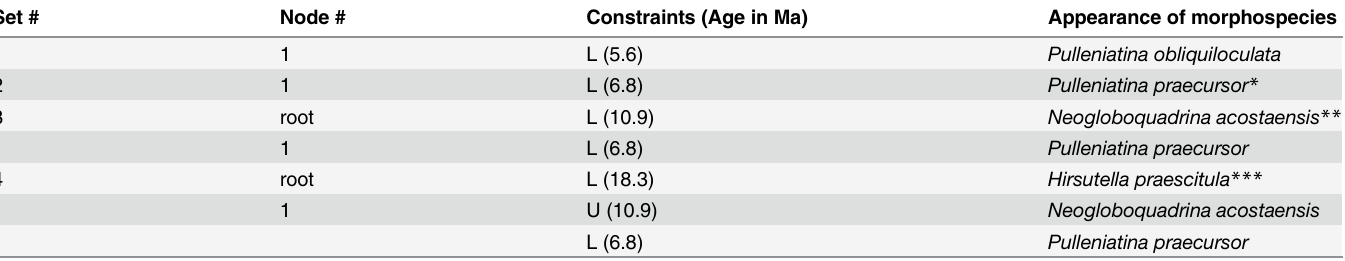
Table 2. Upper (maximum) and Lower (minimum) constraints of the basal nodes used for estimating divergence dates. Set